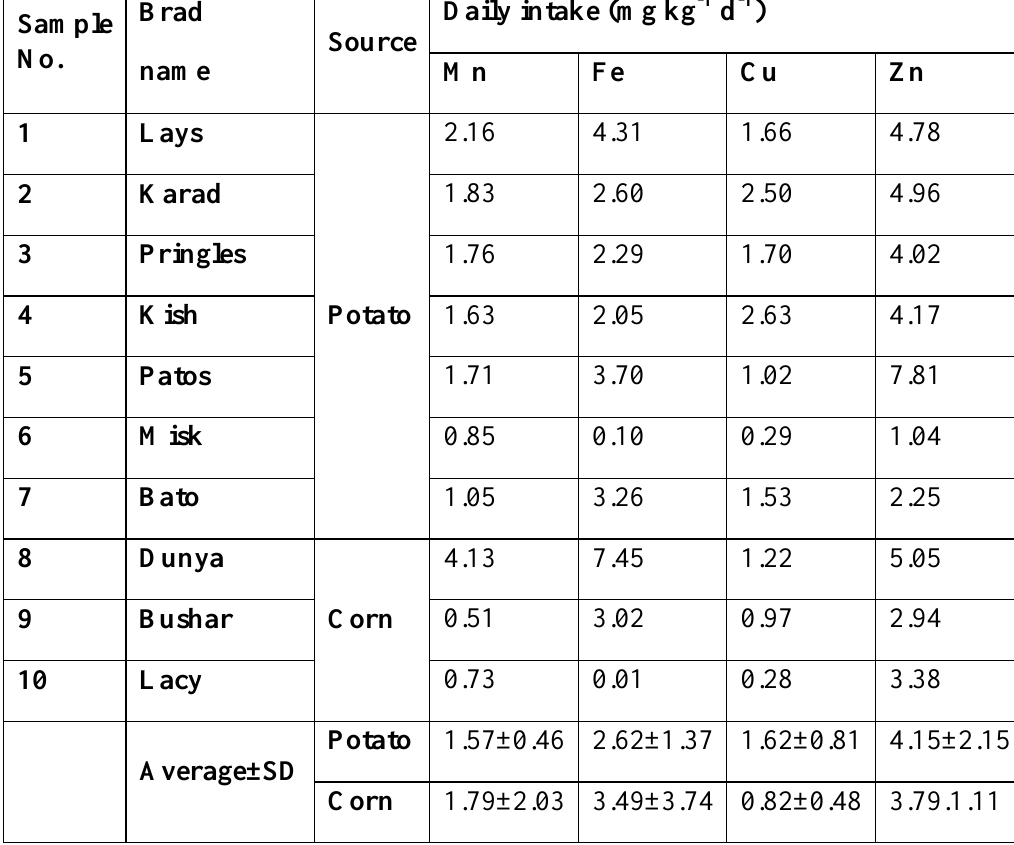
Table 4. The daily intake of the heavy metals in both potato and corn chips